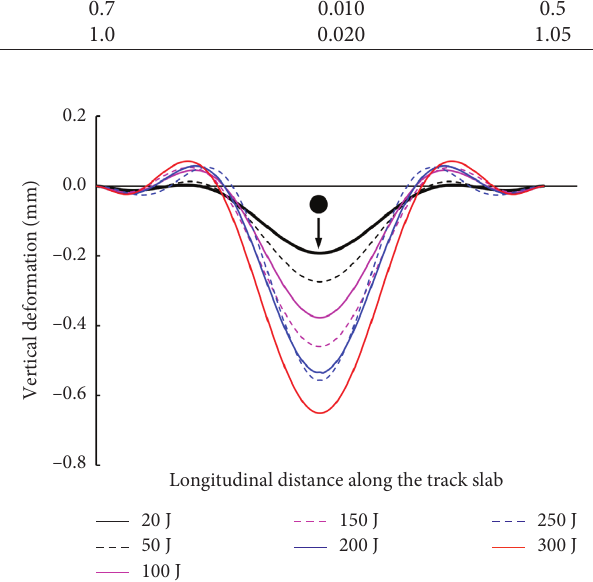
Figure 10: Time histories of the contact force for different impact energies.